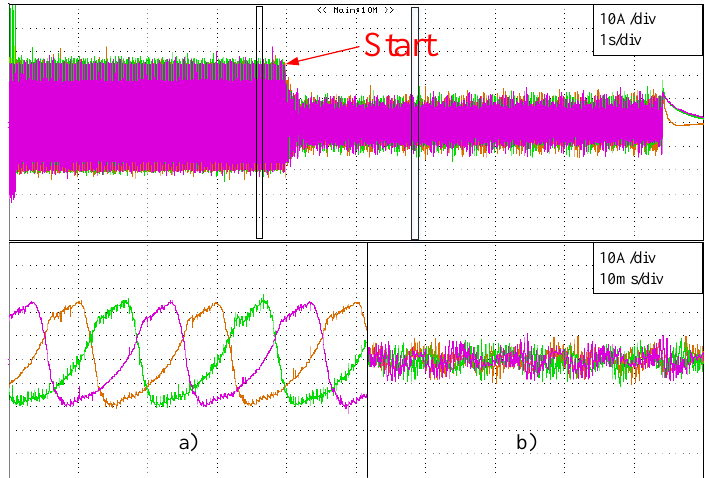
Figure 23. Circulating current comparison with resonant controllers. ( a ) Before controller activation; ( b ) After controller activation.